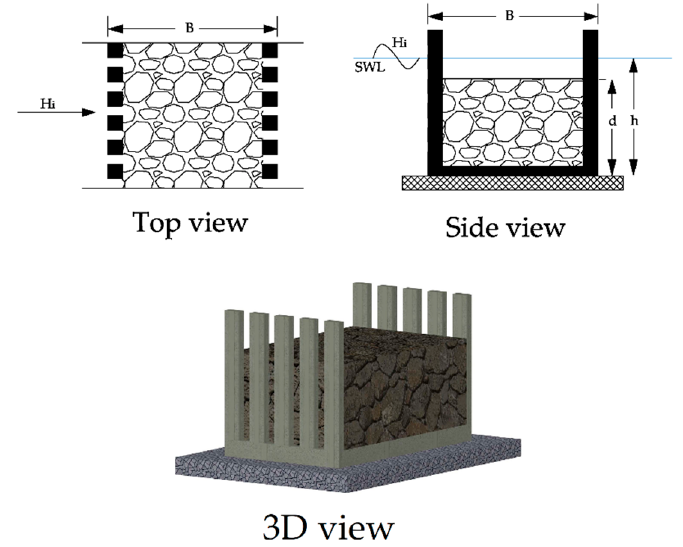
Figure 1. Schematic diagram of the introduced permeable breakwater.